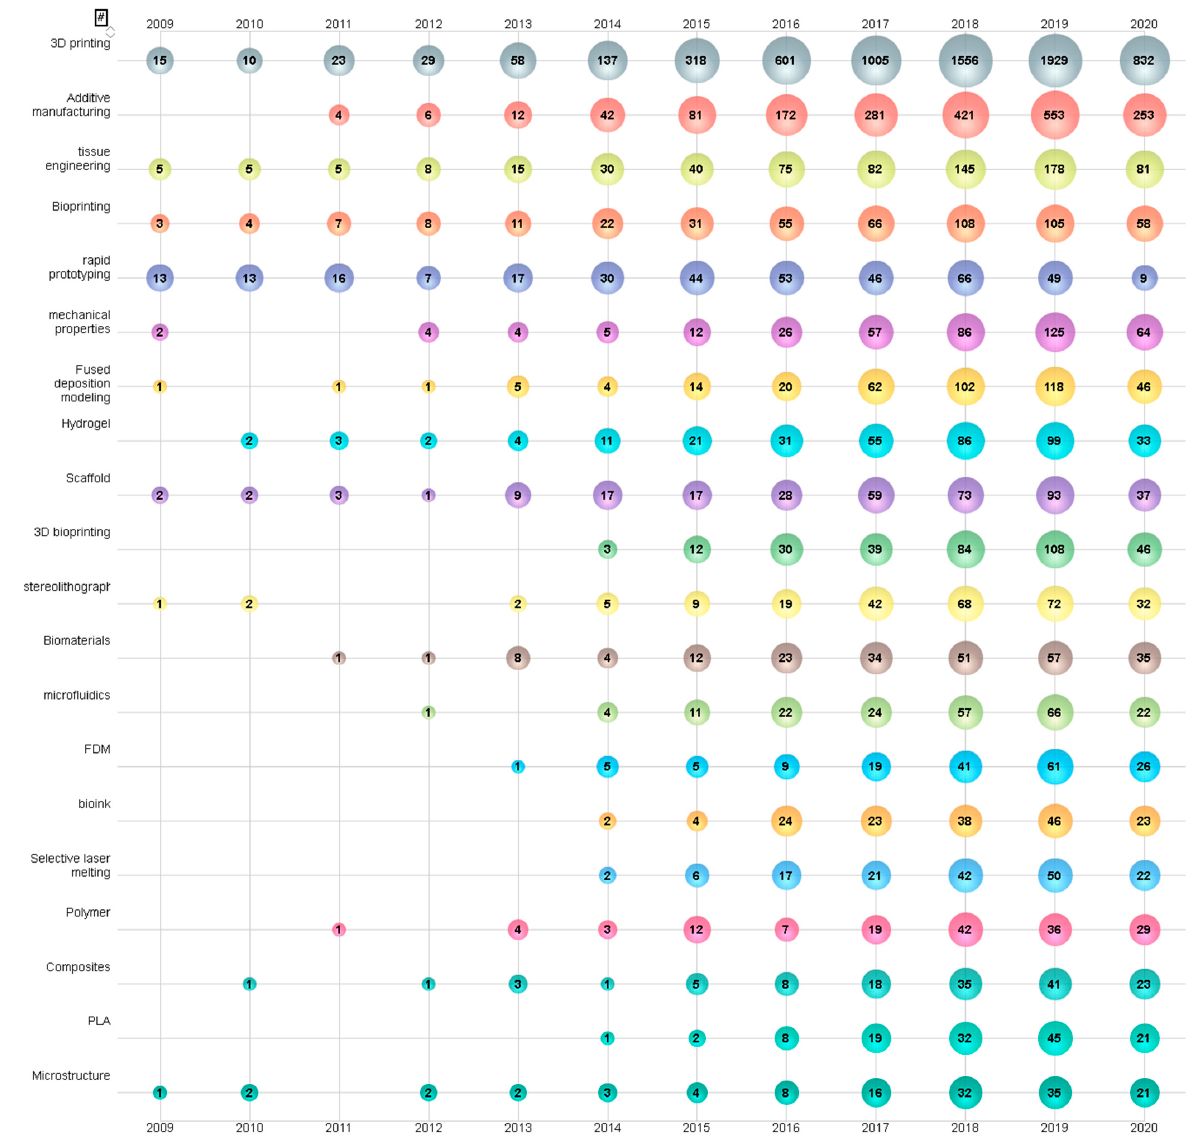
Appl. Sci. 2021 , 11 , x FOR PEER REVIEW Figure 2. Bubble chart of top 20 author keywords by year. Figure 2. Bubble chart of top 20 author keywords by year.